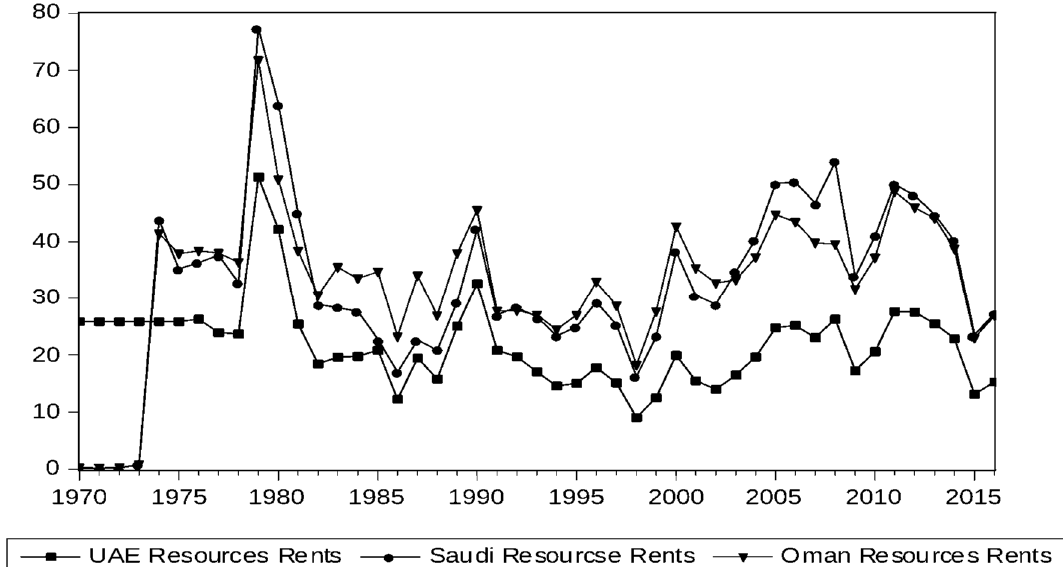
Figure 4. Natural Resources Rents over time (1970–2016). Note: Figure 4 shows Natural resources rents received by UAE, Saudi Arabia, and Oman during the period 1970–2016. Natural resource rents are computed as a percentage of the GDP of the country. Data Source: World Bank databank.